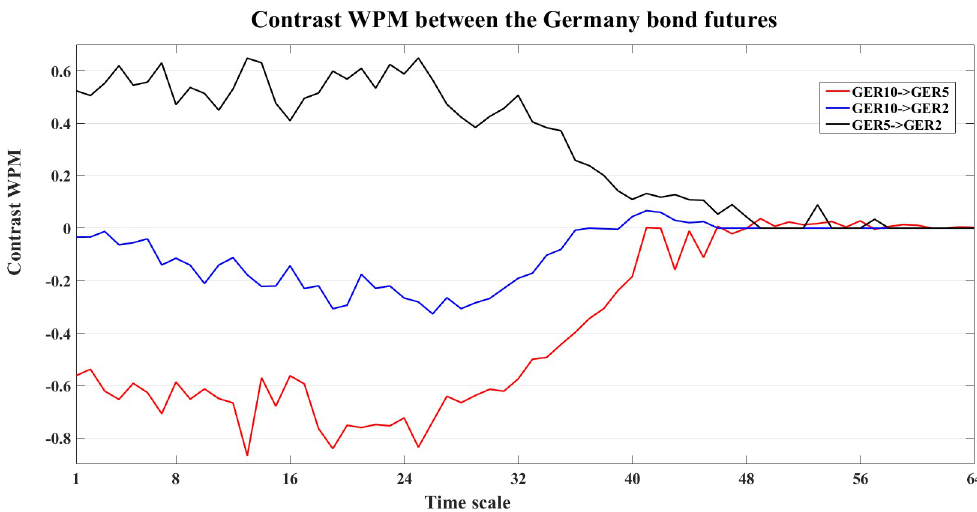
Fig 33. The contrast WPM information transfer values for the Germany bond futures. The line graphs show the contrast WPM values between the Germany bond futures at different time scales s